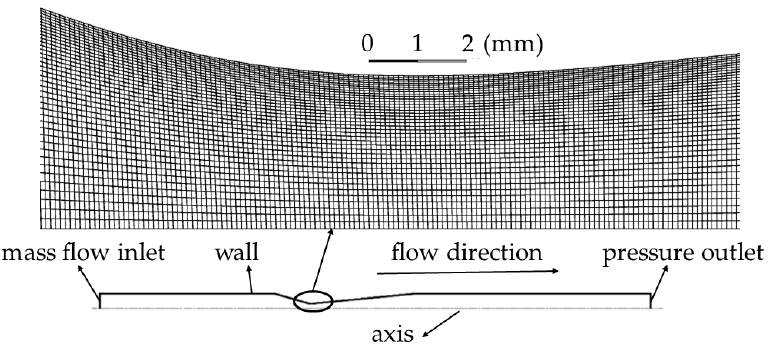
Figure 4. Boundary conditions and mesh of the modeled area of the convergent-divergent nozzle.